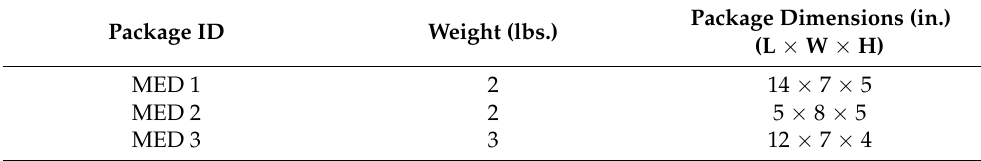
Table 3. Emergency Medical Package